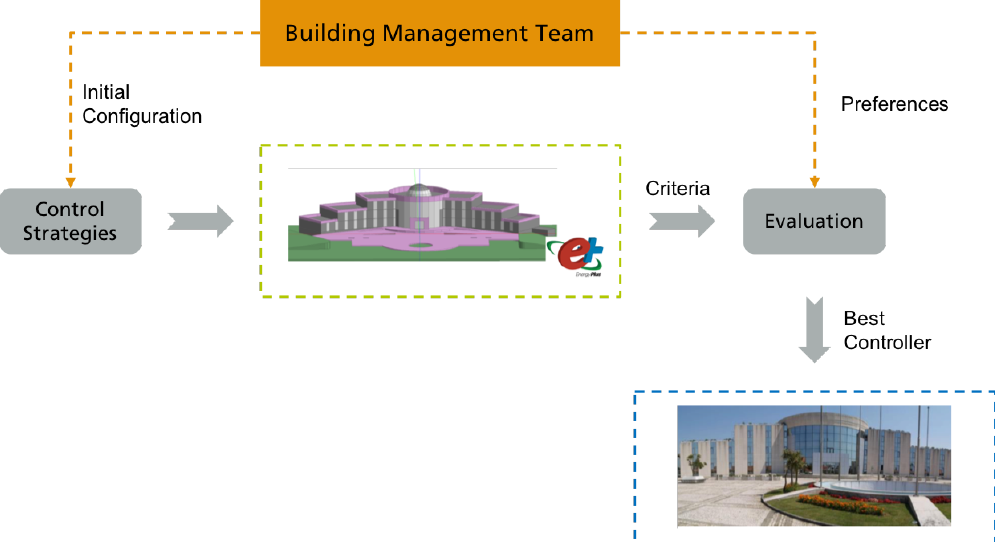
Figure 3. Overview of simulation-based evaluation of building control strategies using multi-criteria decision analysis